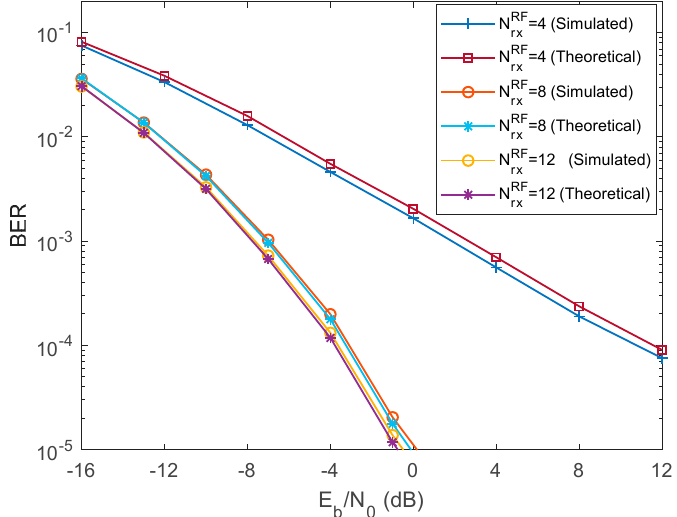
Figure 7. Performance comparison of the proposed hybrid AoD-based precoder between theoretical and simulation cases for N tx = 16 and N rx = 64.